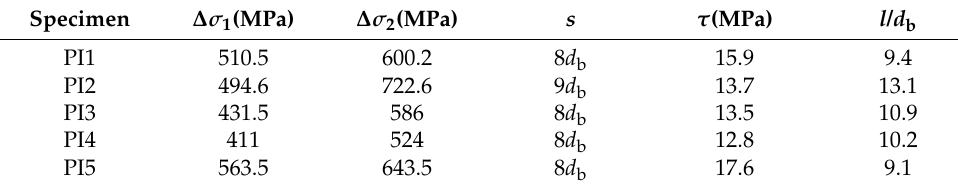
Figure 16. Layout of the strain gauges on the beam top continuous rebars. Table 6. Summary of bond stresses within UHPC joint